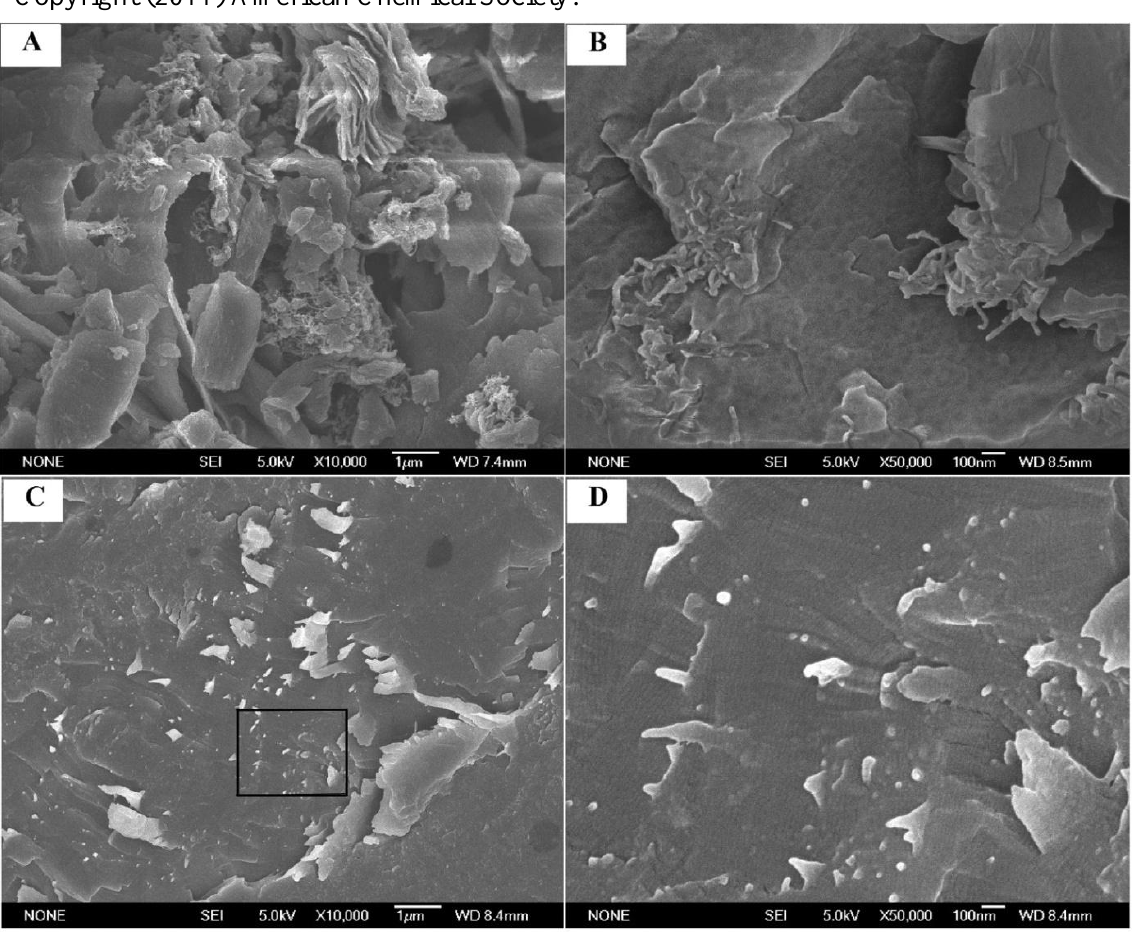
Figure 2. FESEM images of ( A , B ) MWCNT/TLCP composites with 3 wt.% of purified MWCNTs, ( C ) MWCNT-g-TLCP/TLCP composites containing 3 wt.% of